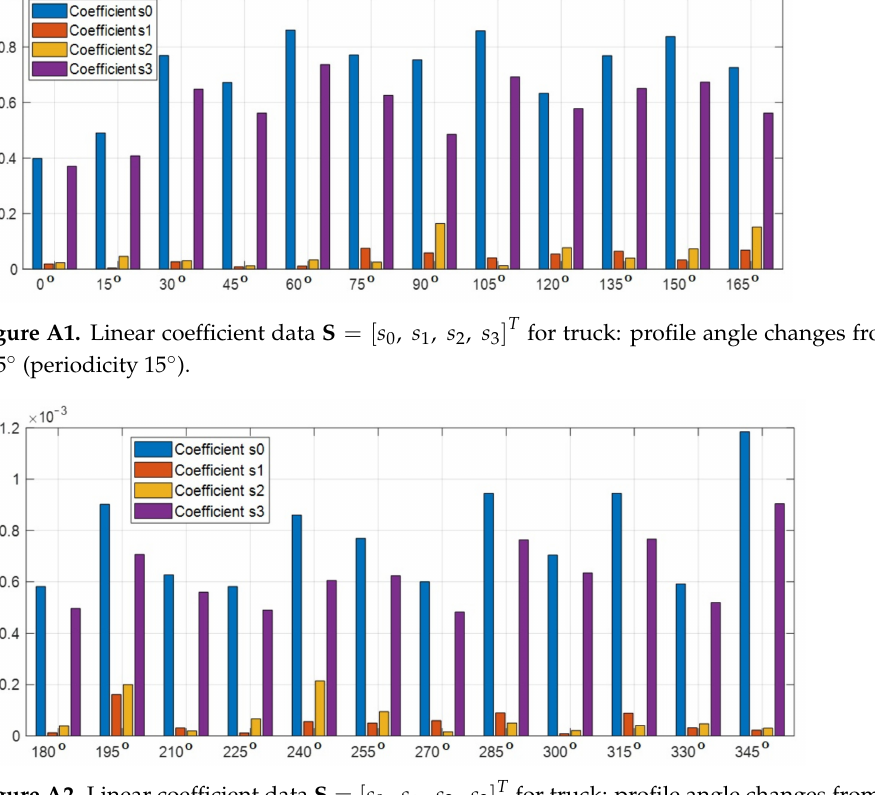
Figure A2. Linear coefficient data S = [ s 0 , s 1 , s 2 , s 3 ] T for truck: profile angle changes from 180 ◦ to 345 ◦ (periodicity 15 ◦ ).